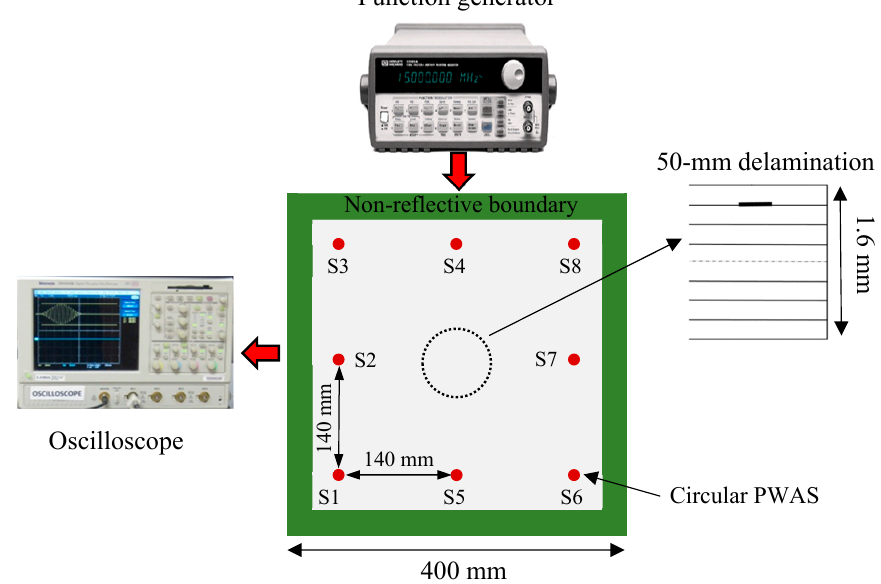
Figure 13. Experimental setup on the 1.6 mm cross-ply composite plate.